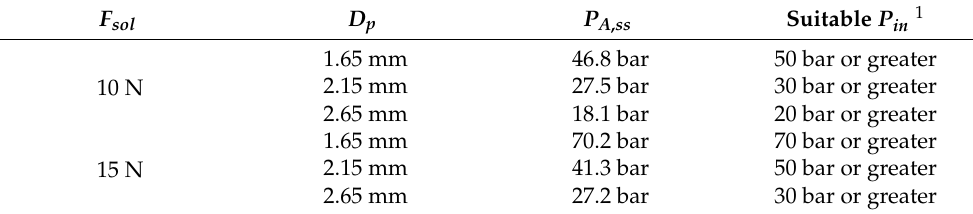
Table 4. Pressure output and solenoid force as related to suitable inlet pressure